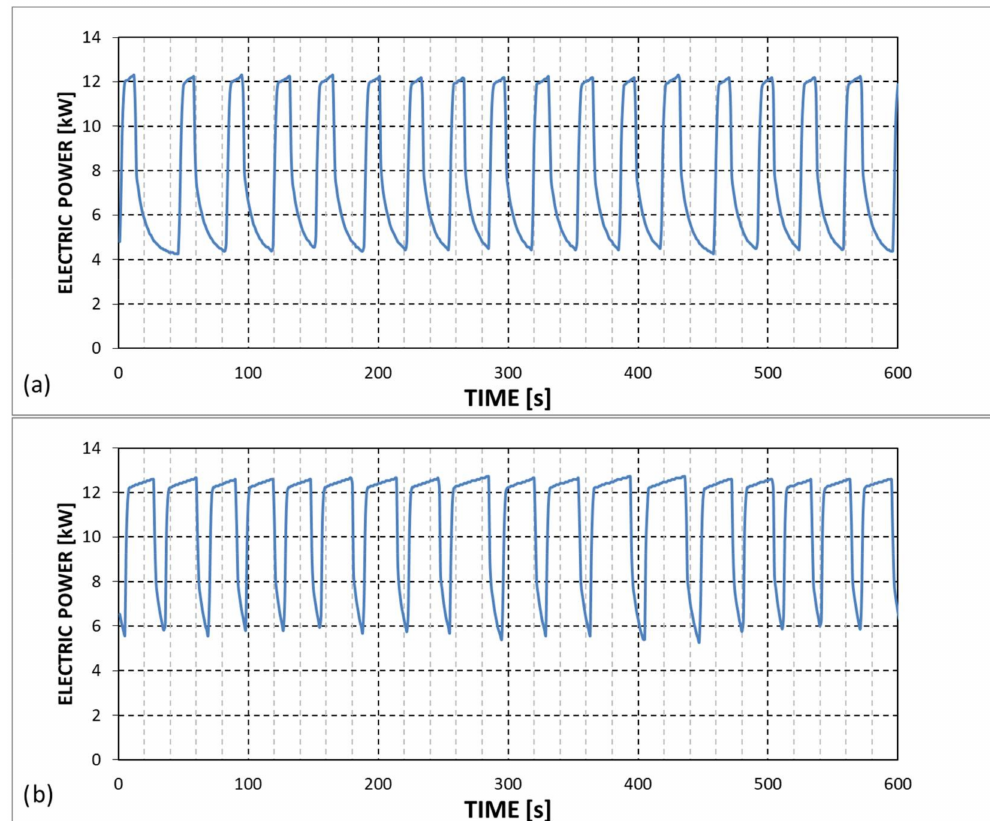
Figure 10. Electric power consumption of the air compressor in an interval of 10 min.